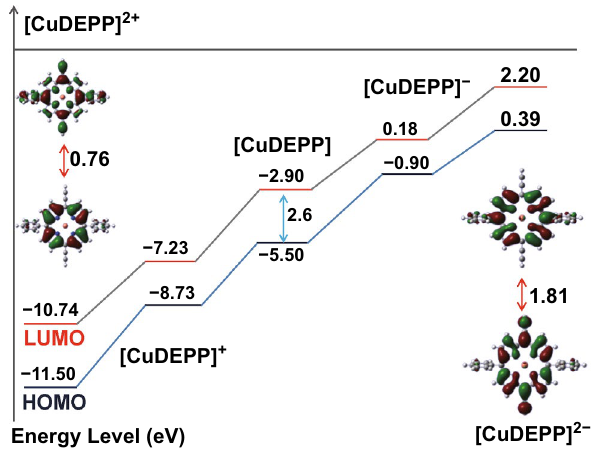
Fig. 8 Energy levels of [CuDEPP], [CuDEPP] + , [CuDEPP] 2+ , [CuDEPP] − , and [CuDEPP] 2− based on DFT simulation